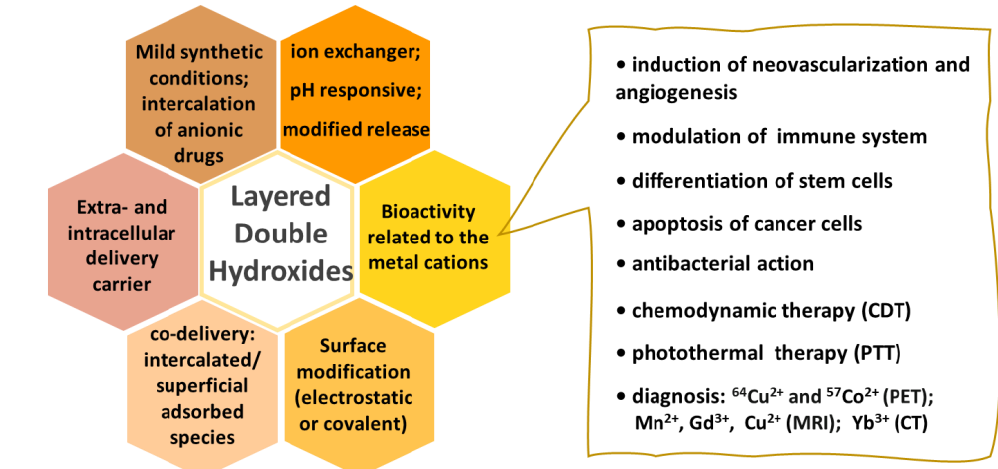
Figure 10. Suitable LDH properties for therapeutic and/or diagnosis purposes.